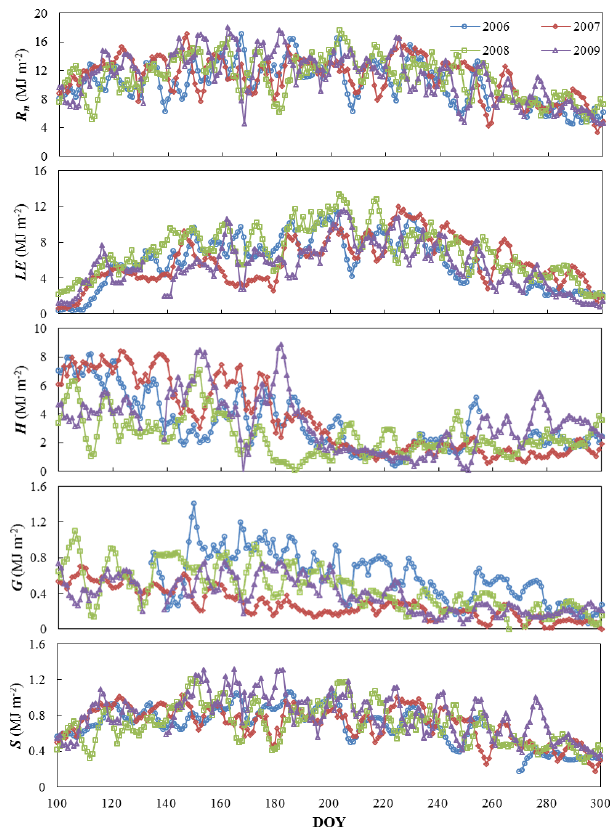
Figure 3. Seasonal patterns of daytime energy components (5-day running average) during the growing seasons from 2006 to 2009, including net radiation ( R n ) , latent heat (LE), sensible heat ( H) , soil heat flux ( G) , and heat storage term ( S) .